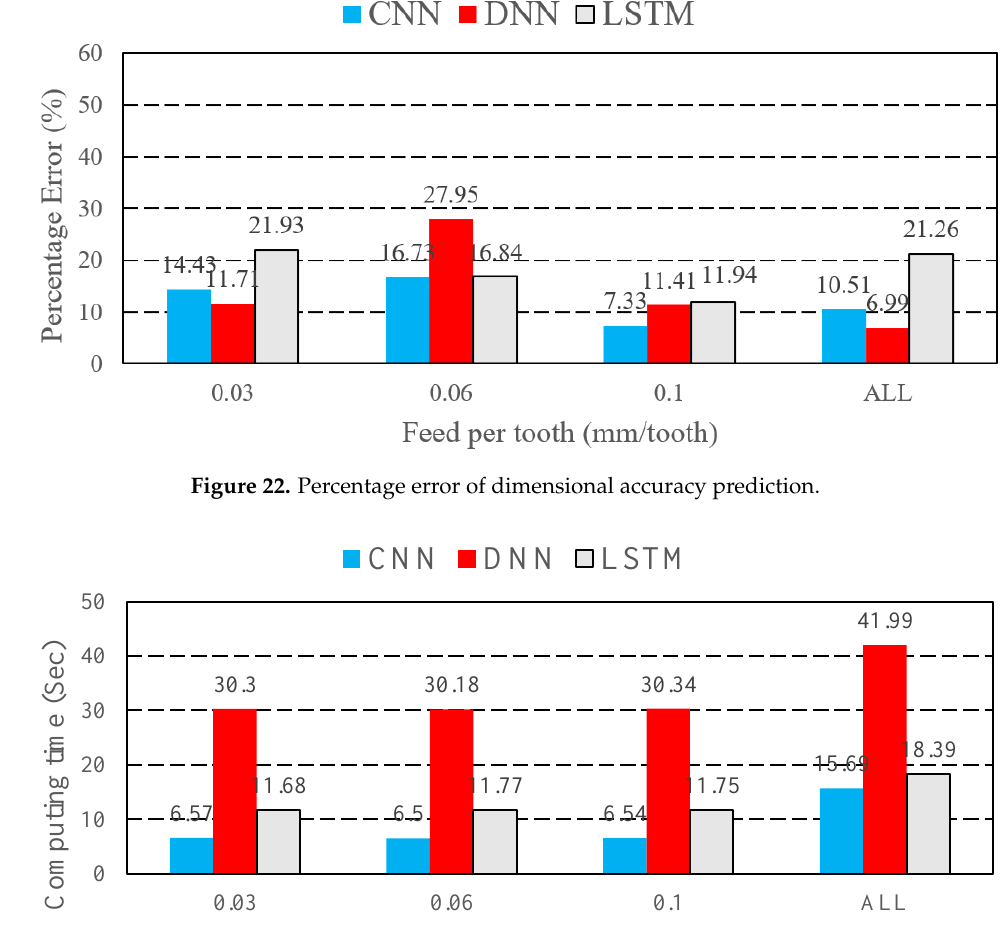
Figure 21. Distribution graph of dimensional accuracy in terms of cutting speed.